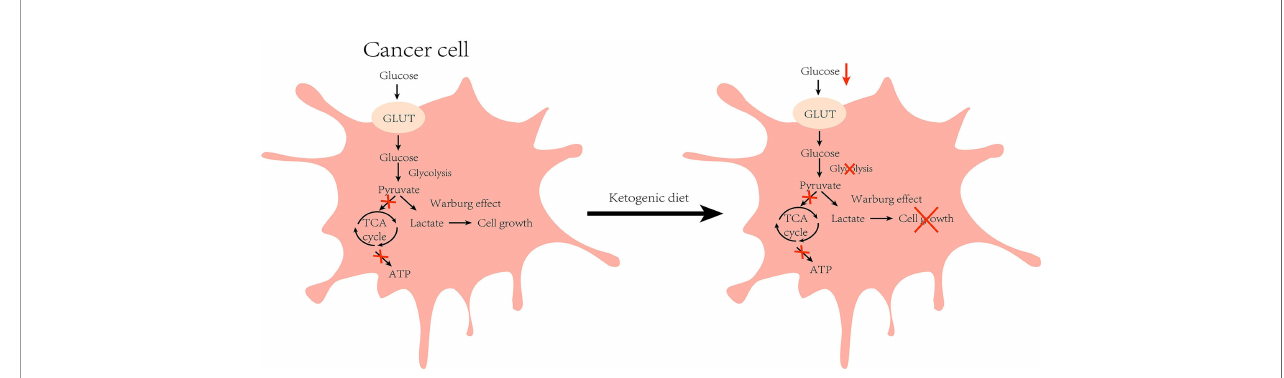
FIGURE 2 | Effect of ketogenic diet on glucose metabolism in cancer cell: Cancer cells are characterized by higher glycolysis due to defective mitochondrial function, and the accumulated cytosolic pyruvate is used to produce lactate (Warburg effect) during normal diet. However, under ketogenic diet feeding, glucose intake is reduced and the growth of cancer cells is inhibited by reduced energy supply. (GLUT,